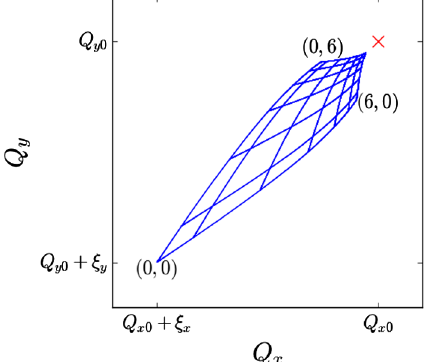
FIG. 2. Tune footprint caused by the beam-beam tune shift in both transverse planes simultaneously. The lines correspond to x= σ ∈ f 0 ; 1 ; 2 ; 3 ; 4 ; 5 ; 6 g and y= σ ∈ ½ 0 ; 6 (cid:3) , or vice versa. The x y markers on the corners of the footprint correspond to the normalized amplitude in horizontal and vertical phase space. The red cross marks the working